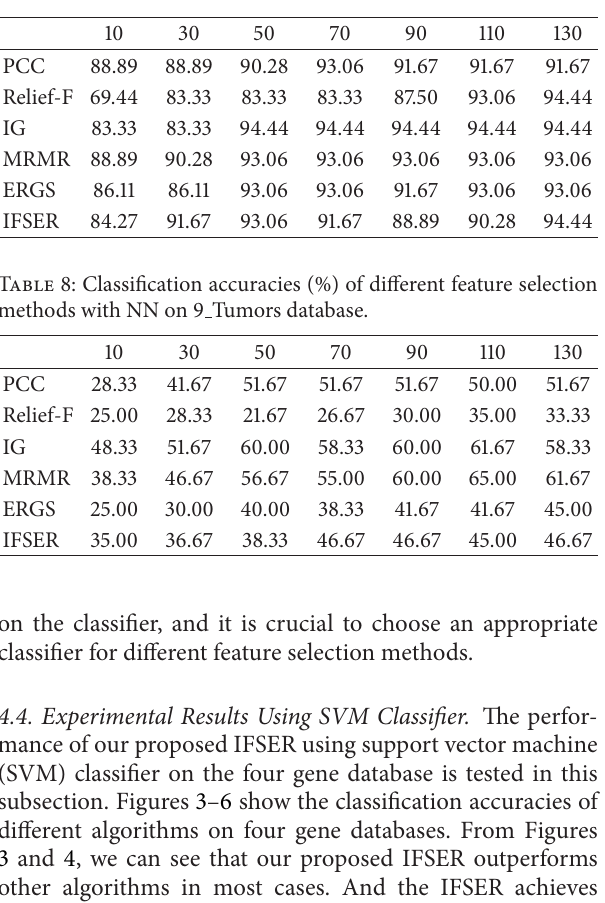
Table 7: Classification accuracies (%) of different feature selection methods with NN on Leukemia2 database.